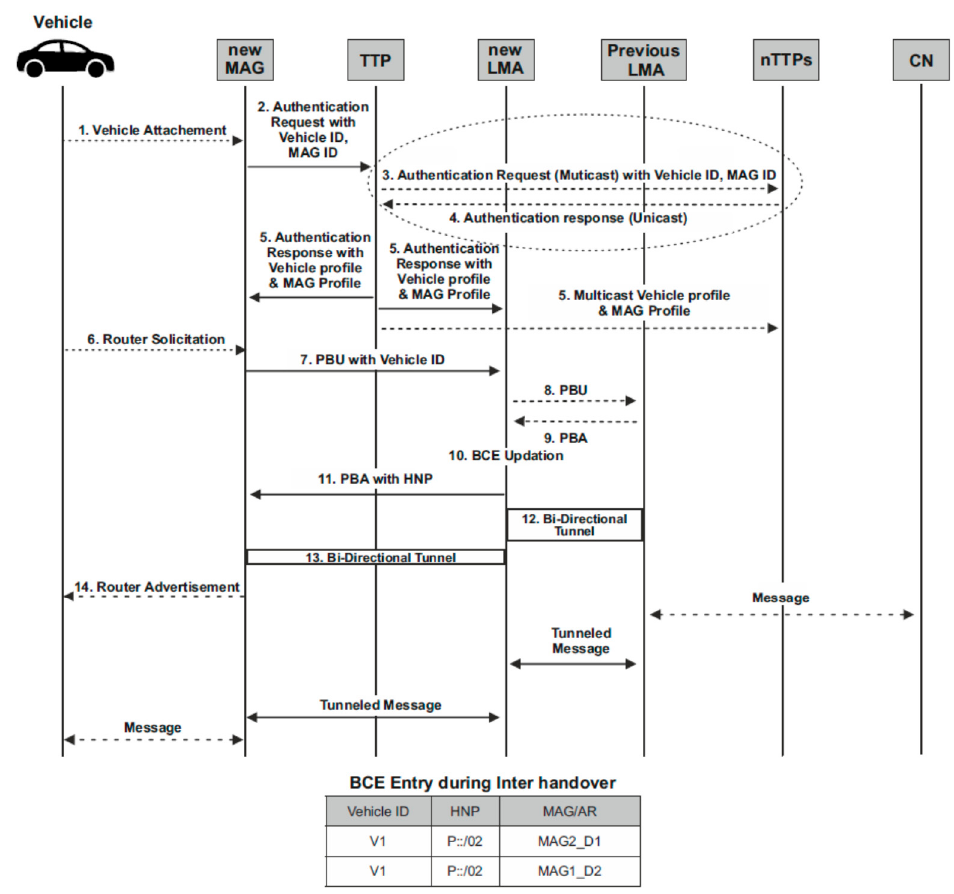
Figure 5. Sequence diagram for inter-domain handover for a vehicle in the PMIPv6 domain.